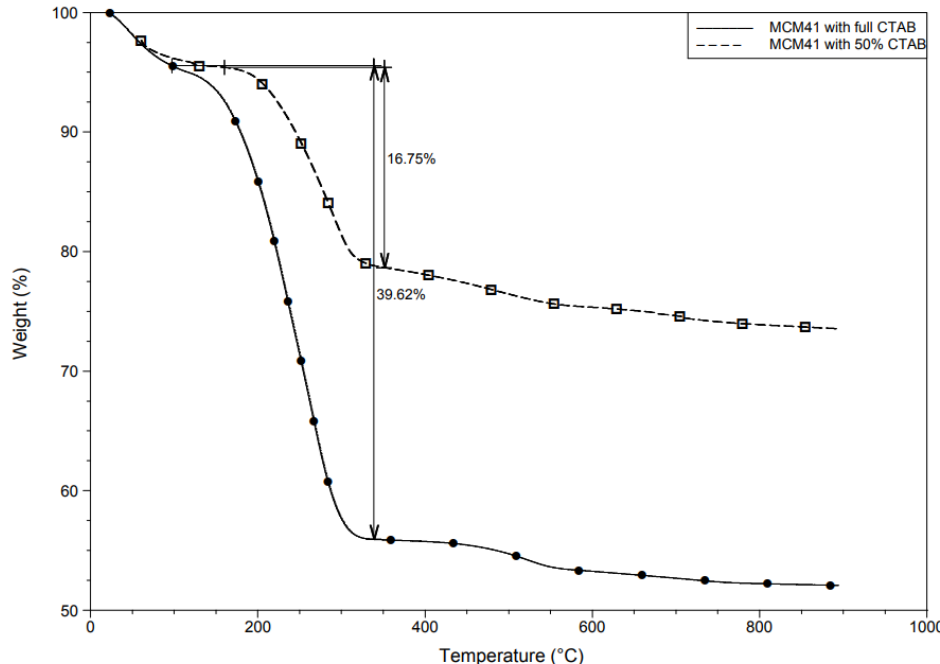
Figure 2. TGA results for the encapsulated surfactant in MCM-41 indicate 40% of total organic content in MCM-41 with the full CTAB sample, while approximately 20% of MCM-41 with the 50% CTAB sample.